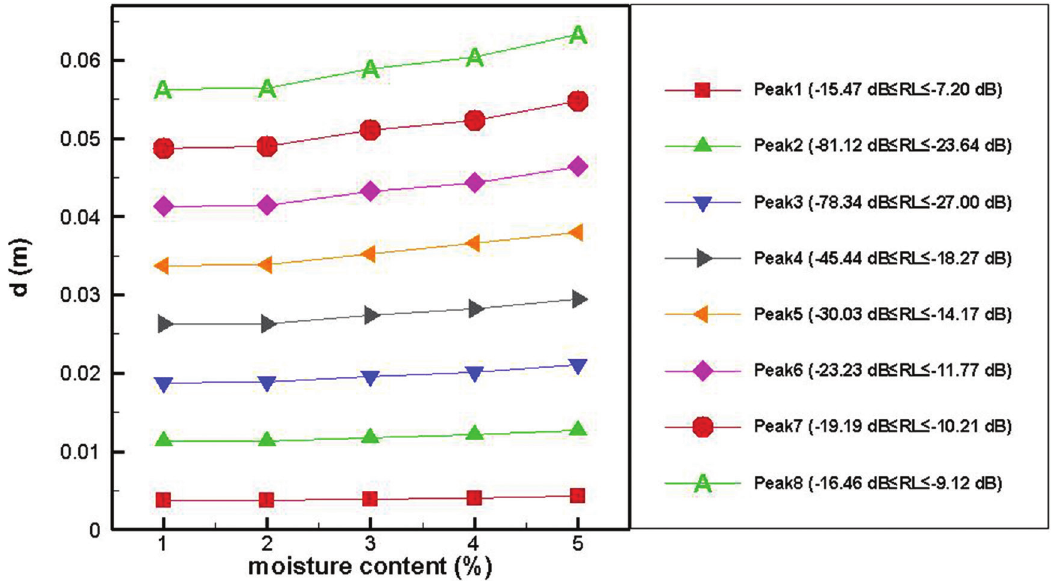
Fig. 3: Absorption peak positions in the RL of the petroleum coke at various moisture contents (20 °C).